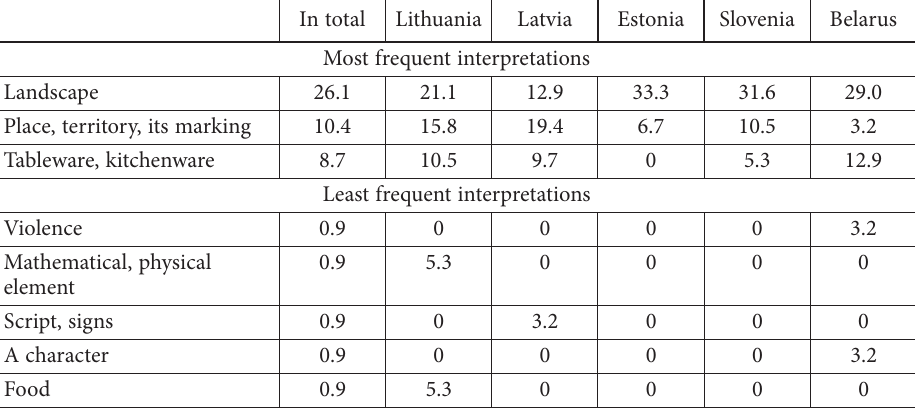
Table 2. Interpretations of Fragment 1 (%) (source: created by authors) In